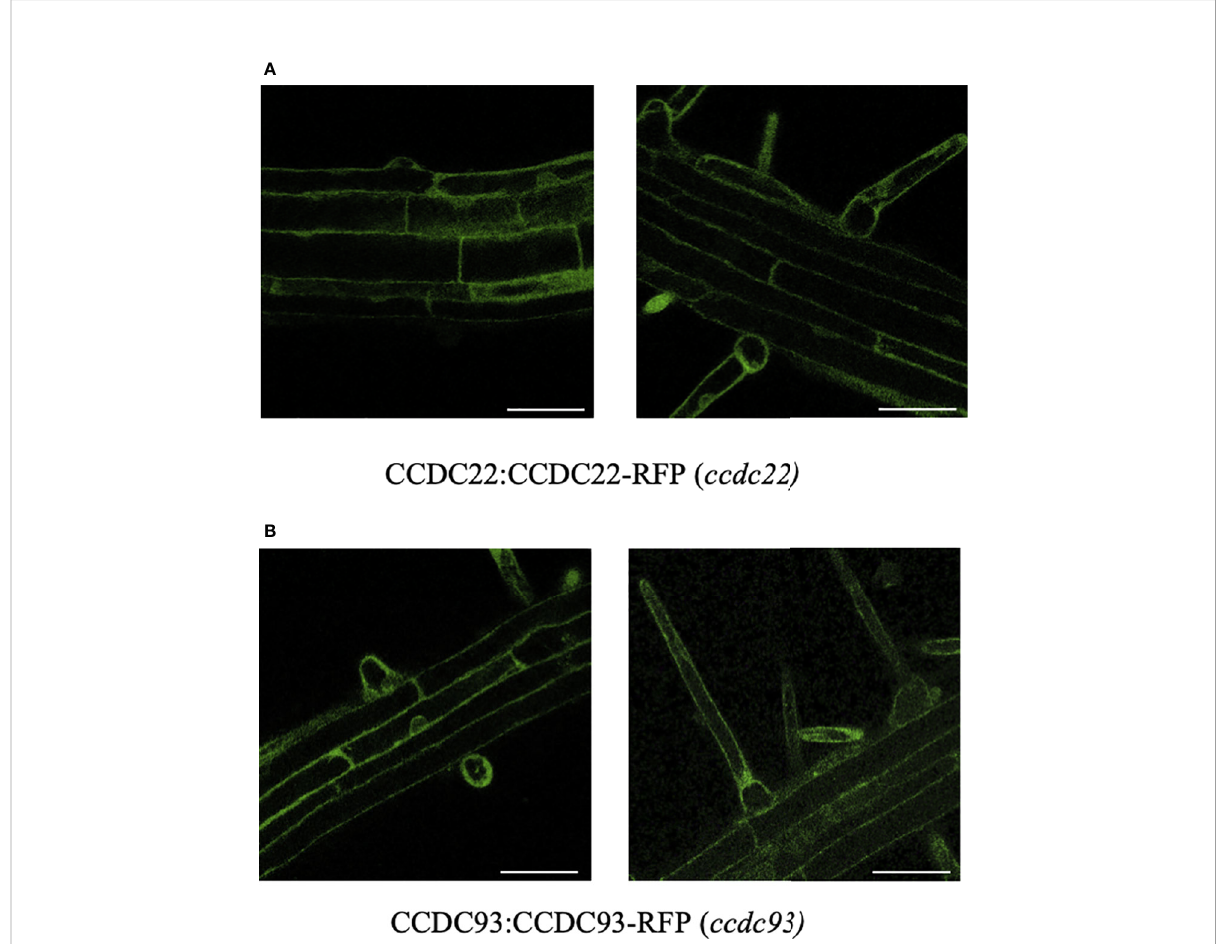
FIGURE 5 CCDC22-RFP and CCDC93-RFP localize to the cytoplasm of root hairs and root epidermal cells. Confocal fl uorescence microscopy was used to visualize (A) CCDC22:CCDC22-RFP (ccdc22-1)and (B) CCDC93:CCDC93-RFP (ccdc93-1)expression in seedling roots. Scalebars are equal to 50 m